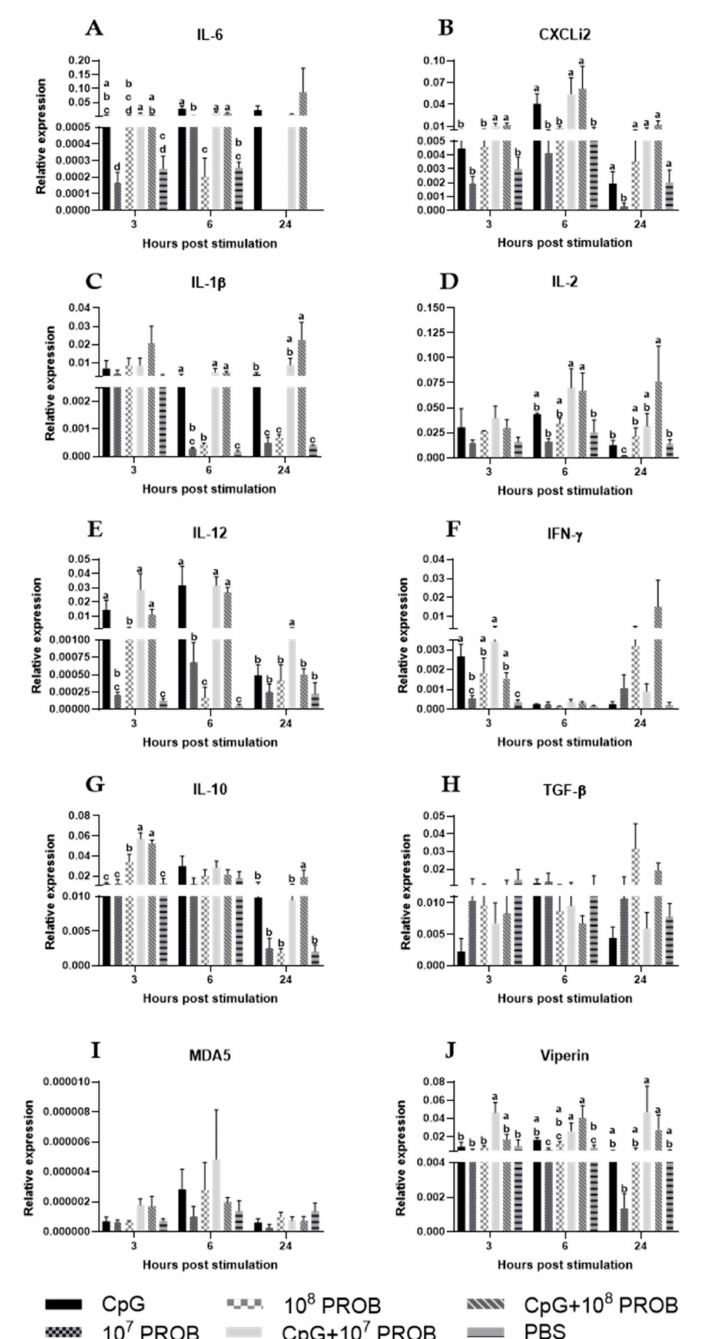
Figure4. Relativeexpressionofcytokine, chemokine, andantiviralgenesinchickenCTmononuclearcells afterstimulationwithlactobacilliand / orCpG.CTmononuclearcellsfromchickens( n = 8 / treatmentgroup) were stimulated with a probiotic lactobacilli cocktail ( Lactobacillus salivairus, L. johnsonii, and L. reuteri ) and / or CpG ODN 2007 for 3, 6, and 24 h. PBS or RPMI 1640 were used as vehicle controls. At each time point, CT mononuclear cells were collected in TRIzol ® for RNA extraction. Because of low RNA yield, RNA samples were pooled after RNA extraction. There were four biological replicates / treatment group / time point. After cDNA synthesis and qRT-PCR, the expression levels of target genes, as well as the housekeeping gene ( β -actin), were determined. The expression levels are shown as relative to β -actin. Error bars indicate standard error of the mean of four biological replicates. Different letters indicate a significant difference between different treatments within a time point ( p < 0.05). Treatment groups were: 5 µ g / mL CpG ODN 2007 (CpG), 10 7 CFUs of lactobacilli (10 7 PROB), 10 8 CFUs of lactobacilli (10 8 PROB), CpG + 10 7 PROB, CpG + 10 8 PROB and phosphate-buffered saline